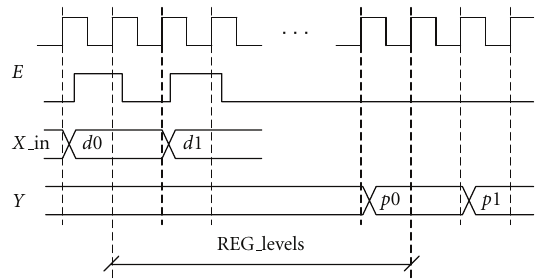
Figure 6: Latency measured from the moment “ d 0” is input until its correspondent output “ p 0” is available.